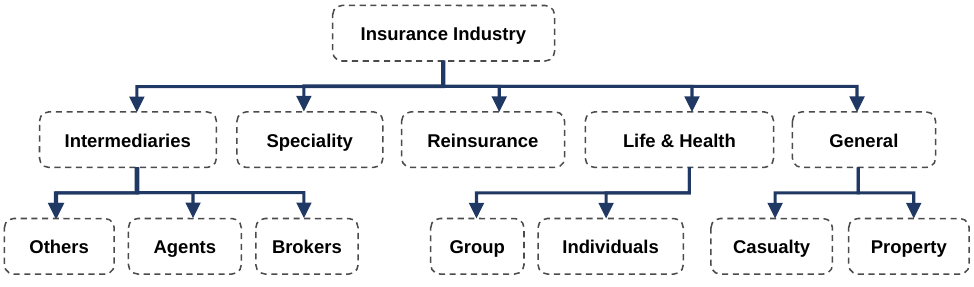
Figure 1. Taxonomy of the insurance industry according to Boobier [2].